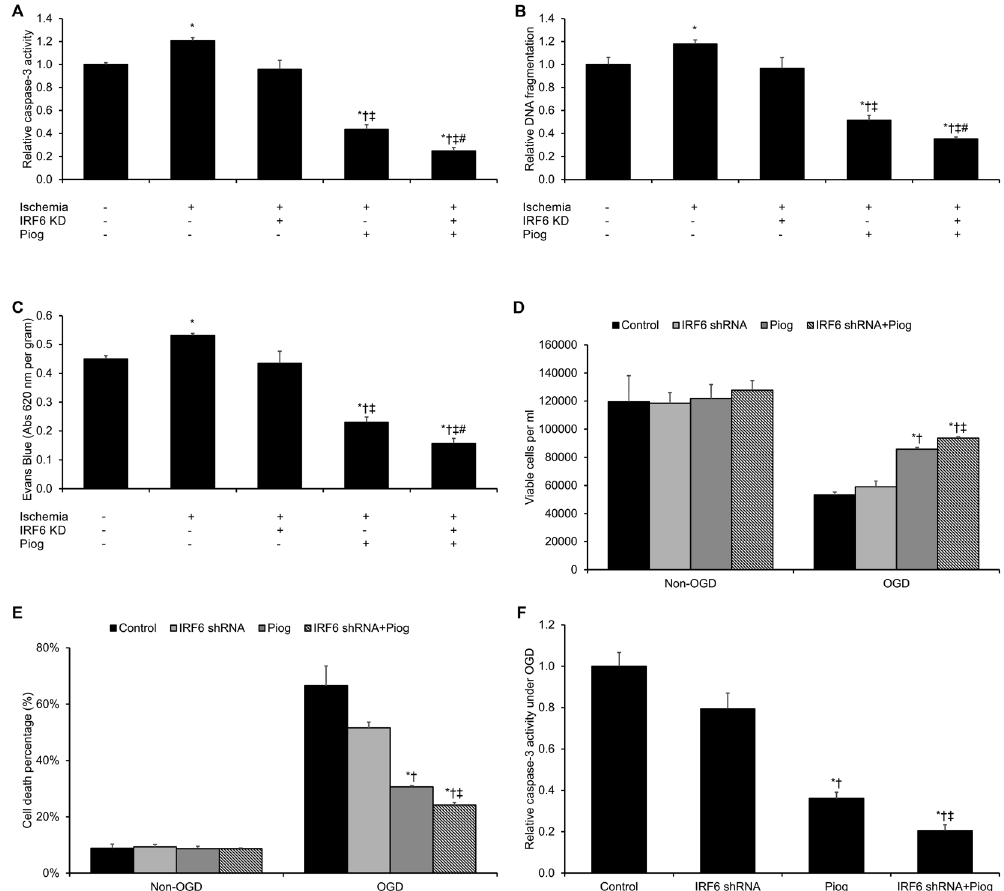
Figure 3. IRF6 Knockdown Potentiates Pioglitazone-Driven Cytoprotection in Cerebrovascular Endothelial Cells Following Ischemic Insult. ( A–C ) Wild-type mice or adenoviral-mediated IRF6 knockdown mice were treated with pioglitazone following middle cerebral artery (MCA) occlusion. After 24 hours of MCA reperfusion, cerebral microvessels were isolated and assessed for ( A ) caspase-3 activity and ( B ) DNA fragmentation. ( C ) Cerebrovascular permeability by Evans Blue extravasation was also assessed following 24 hours of MCA reperfusion. Pioglitazone significantly reduced caspase-3 activation, DNA fragmentation, and cerebrovascular permeability in wild-type mice. Notably, pioglitazone-driven vasoprotection was potentiated in IRF6 knockdown mice. * P < 0.05 versus sham group, † P < 0.05 versus Ischemia group, ‡ P < 0.05 versus Ischemia + IRF6 KD group, # P < 0.05 versus Ischemia + Piog group. ( D–F ) Control and IRF6 shRNA murine cerebrovascular endothelial cells were pre-treated with pioglitazone prior to oxygen-glucose deprivation (OGD) exposure. We assayed ( D ) cell viability by MTT assay, ( E ) cell death by the lactate dehydrogenase (LDH) kmethod, and ( F ) caspase-3 activity. IRF6 silencing potentiated pioglitazone-driven cytoprotection under in vitro OGD conditions. * P < 0.05 versus same-condition Control group, † P < 0.05 versus same-condition IRF6 shRNA group, ‡ P < 0.05 versus same-condition Piog group. Data are reported as means ± standard errors of the mean